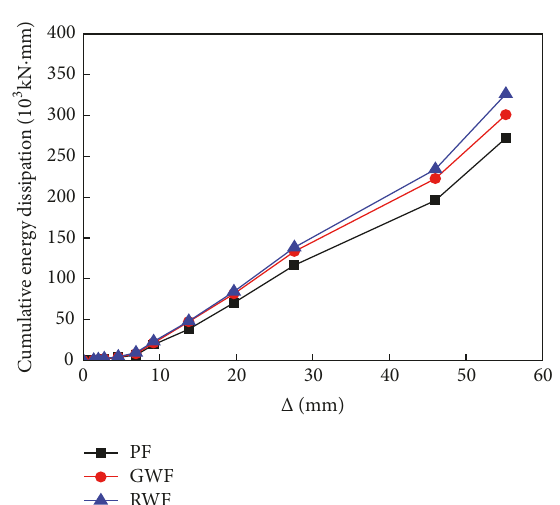
Figure 8: Relationship between cumulative energy dissipation and